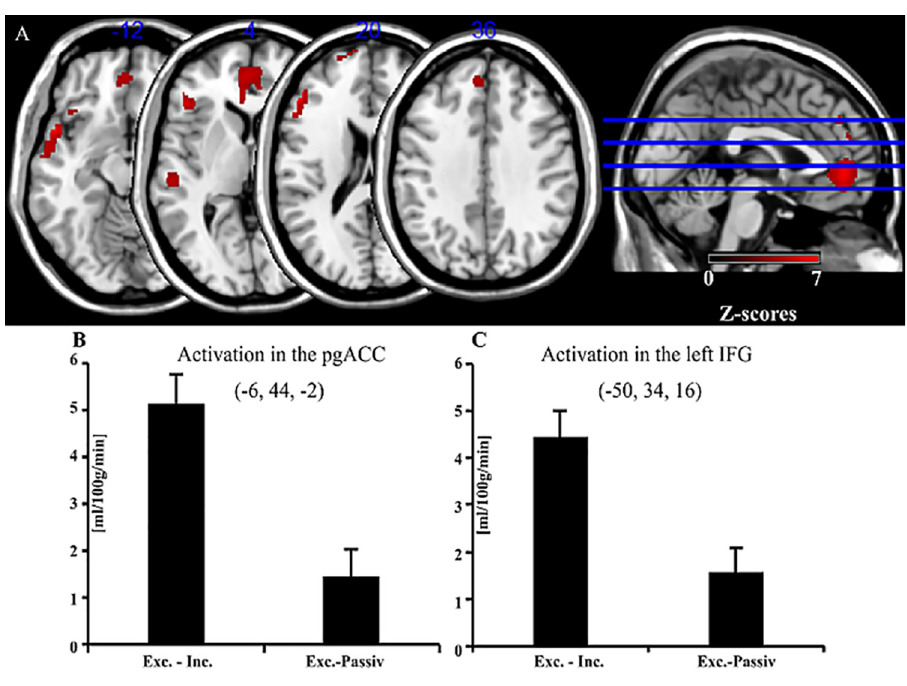
Fig 1. Main effect: Exclusion minus inclusion in the Cyberball game. (A) Main effect: Exclusion minus inclusion in the Cyberball game. (B-C) Bar graphs show average perfusion changes and standard errors of peak voxels in sgACC and left IFG in the contrasts of exclusion—inclusion and exclusion—passive viewing. Abbreviations: A.: pgACC, pregenual anterior cingulate cortex; IFG, inferior frontal gyrus. B-C.: Exc, Exclusion; Inc., Inclusion; Passiv, Passive viewing. While not of primary interest, differences between social exclusion and passive viewing were plotted as a reference to show that the differences between social exclusion and social inclusion were diminished since passive viewing is already different from the inclusion condition along this dimension, that is, passive viewing has more in common with the exclusion condition than with the inclusion condition.